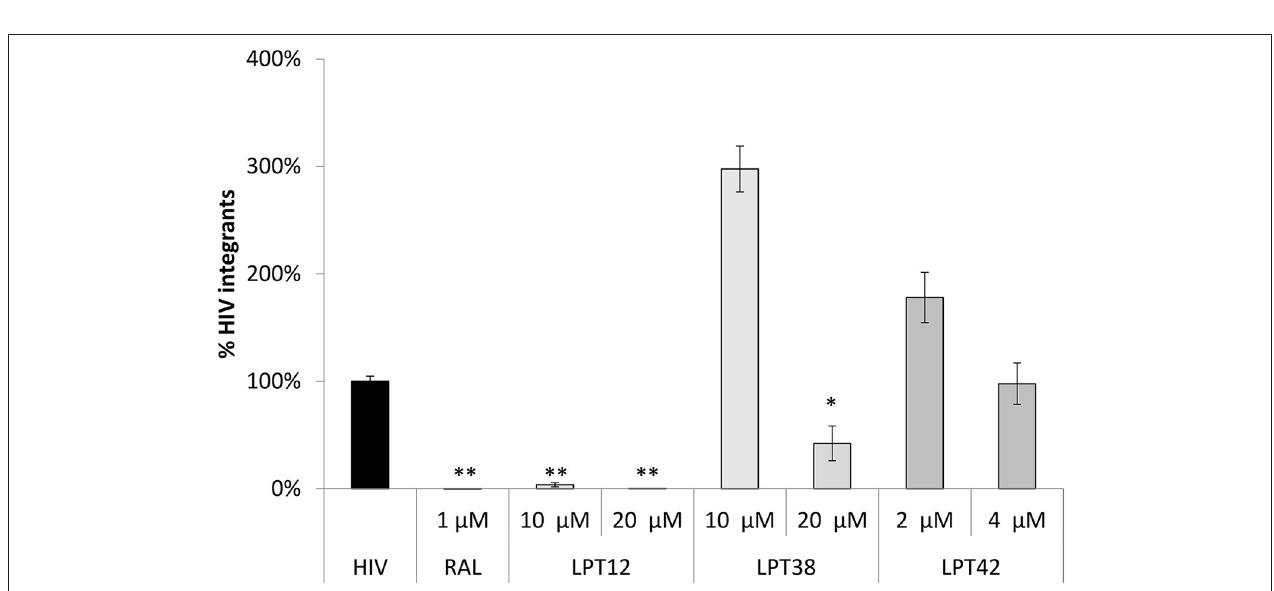
FIGURE 4 | LPTs activity on HIV-1 integration. Analysis by qPCR of HIV integration in MT-2 cells treated with AZT (1 µ M), LPT12 (10 and 20 µ M), LPT38 (5 and 10 µ M) or LPT42 (2 and 4 µ M) and infected with NL4.3 wild type HIV-1 (HIV). Results are shown as % of HIV-1 integrants. The untreated control (HIV) represents the maximum of HIV-1 integrants detected (100%). CCR5 was used as housekeeping gene. ANOVA analysis was performed to determine the value of p (* p < 0.05, ** p < 0.01,*** p <